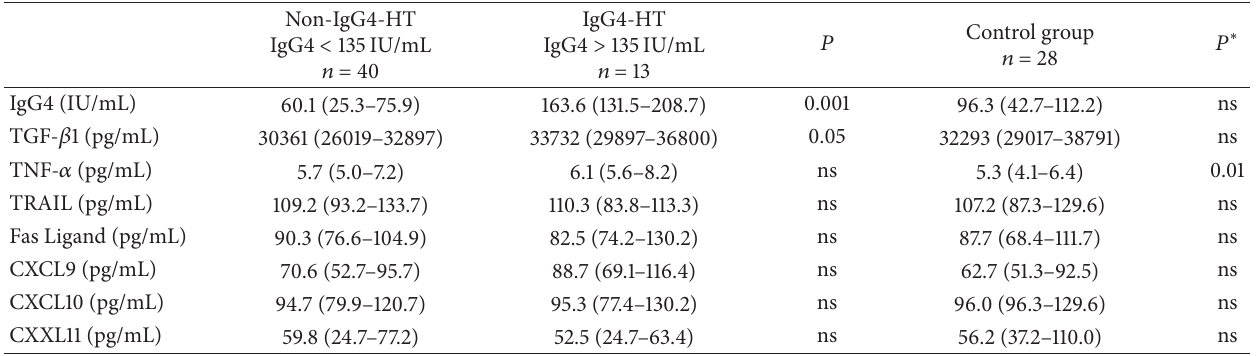
Table 3: Proinflammatory cytokines and apoptotic markers in the patients with non-IgG4-HT, IgG4-HT, and the control